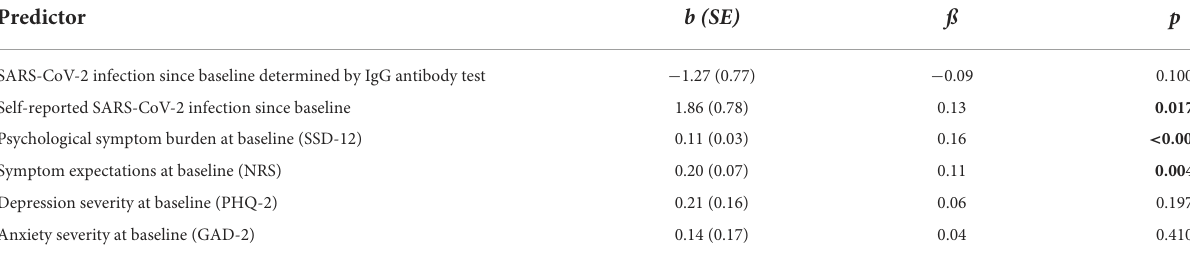
TABLE 2 Multiple linear regression analysis to test predictors of somatic symptom change ( 1 SSS-8) at follow-up, adjusting for age, gender, and somatic symptom burden at baseline ( n = 751).